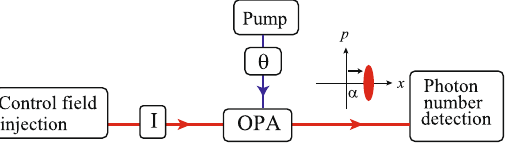
Figure 1. Sketch of the generation and detection of